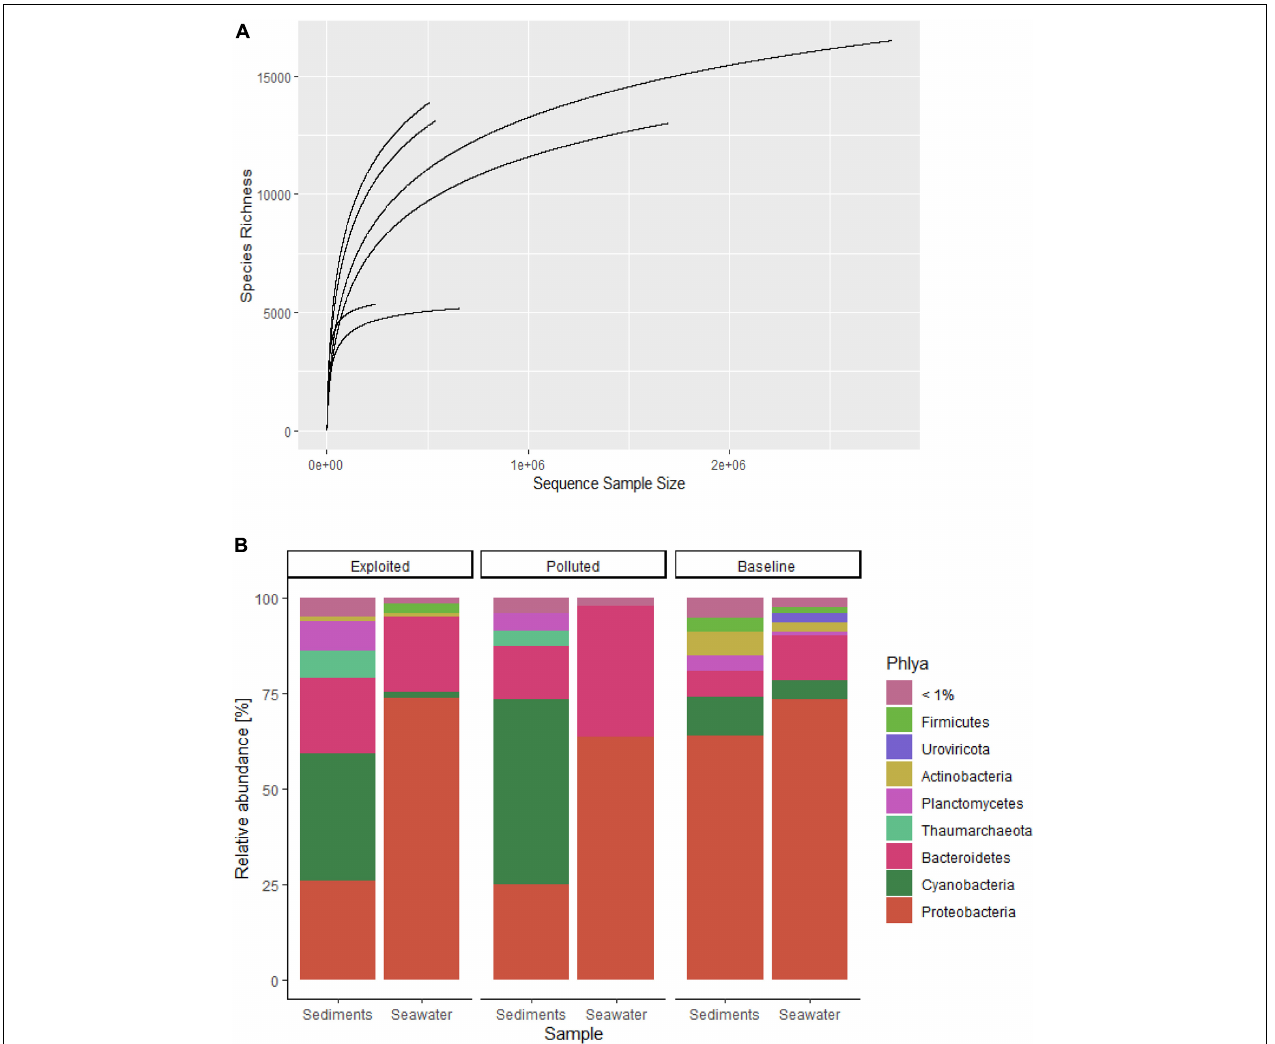
FIGURE 2 | (A) Rarefaction curves for community species richness, and (B) stacked charts of the distribution of community phyla with relative abundance > 1% sequenced from near-coral seawater and sediment samples from Kenya reefs at Malindi (Exploited), Mombasa (Polluted) and Kisite-Mpunguti (Baseline) Marine National